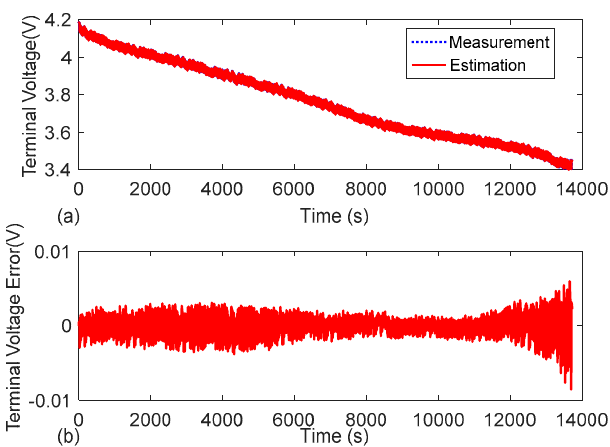
Figure 7. Terminal voltage estimation result: ( a ) Terminal voltage; ( b ) Estimation error.